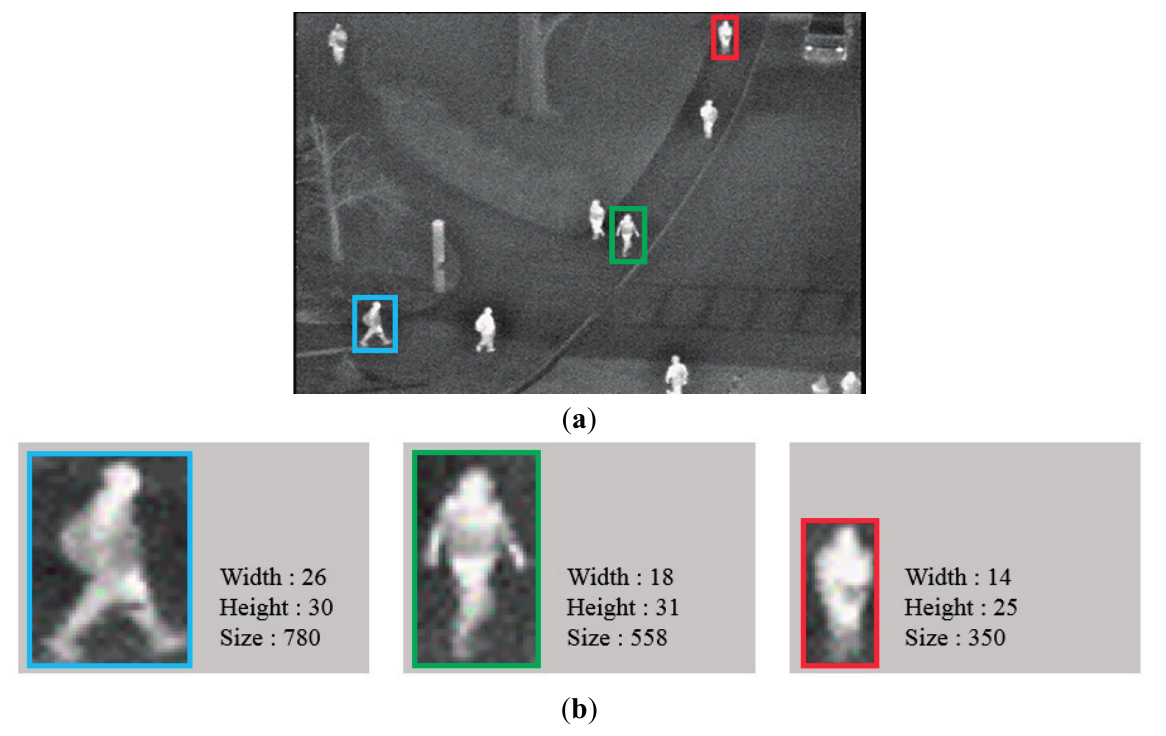
Figure 9. Example of different sizes of human areas resulting from camera viewing direction and perspective projection: ( a ) input image, including three detected areas of humans; and ( b ) information of the width, height and size of the three detected human areas,